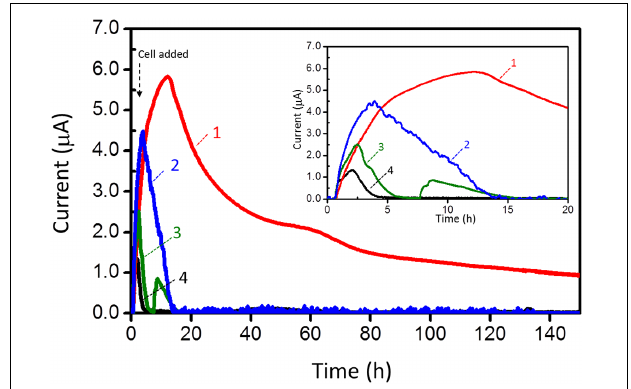
FIGURE 3 | Anodic current ( I ) vs. time ( t ) measurements for 110S cultures containing ferrihydrite (trace 1: 10 mM, trace 2: 2.5 mM) and hematite (trace 3: 10 mM). Current generation in the absence of iron oxides was also shown in trace 4. Electrode potential was +200 mV. Cell density was adjusted to OD 600 =